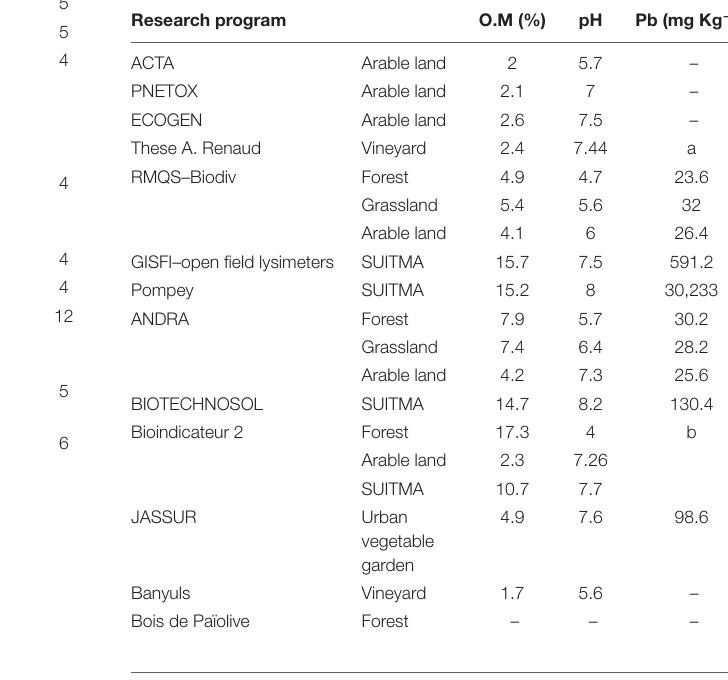
TABLE 2 | Main geochemical parameters of each soil under various land uses from the 13 research